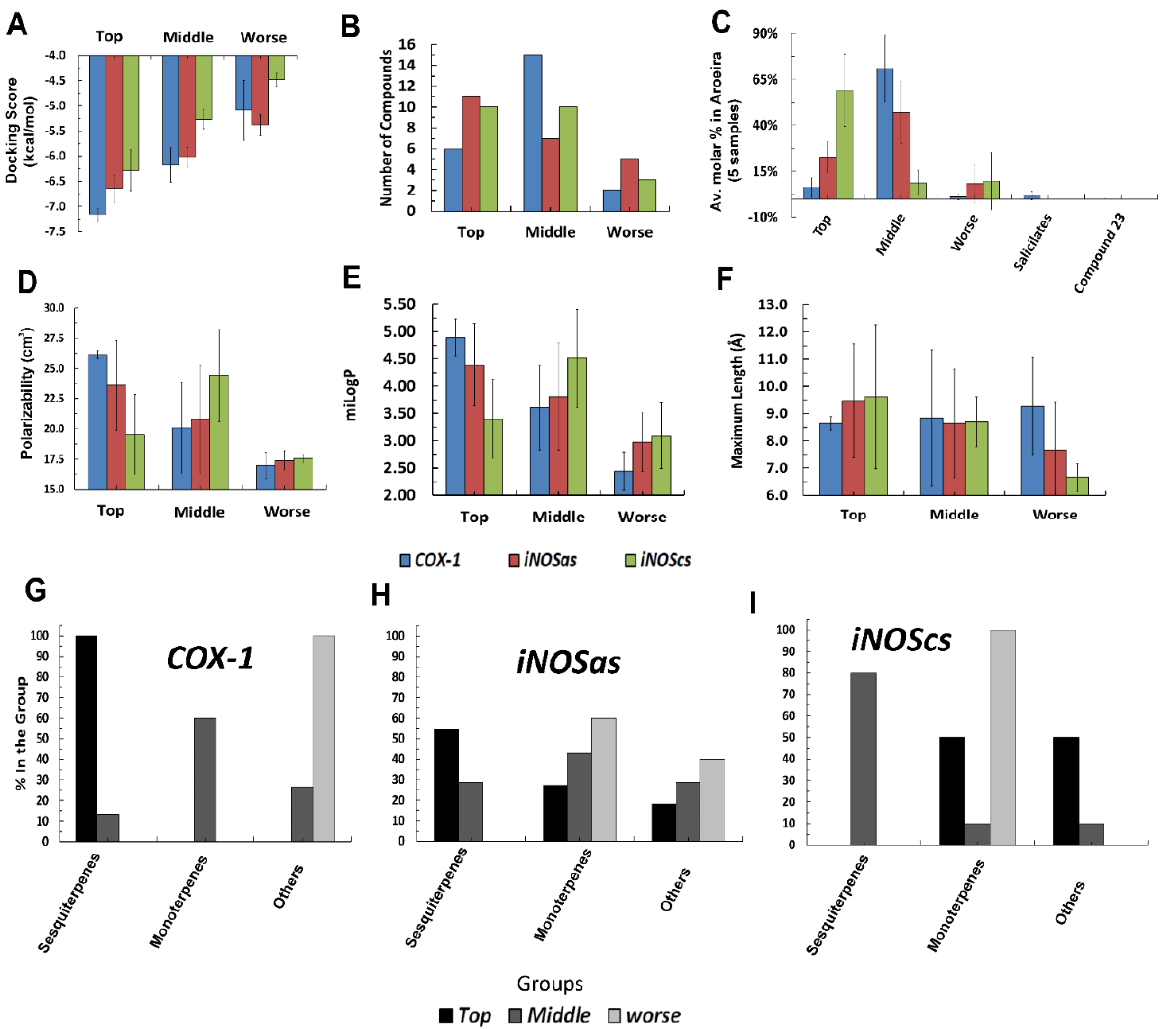
Figure 6. Statistics and numbers concerning the aroeira compounds classified according to their respective virtual affinities for the three targeted sites. ( A – F )-respective plots of the docking scores, number of compounds (between the 23 profiled), average percent of the compounds at the five samples, average polarizability, miLogP and maximal length, according to the compounds belong to the top , middle , or worst groups for COX-1, iNOSas and iNOScs. ( G – I )-Respective plots for COX-1, iNOSas and iNOScs of the percent of sesquiterpenes, monoterpenes and other classes at each one of the top , middle , and worst docking score classifications.